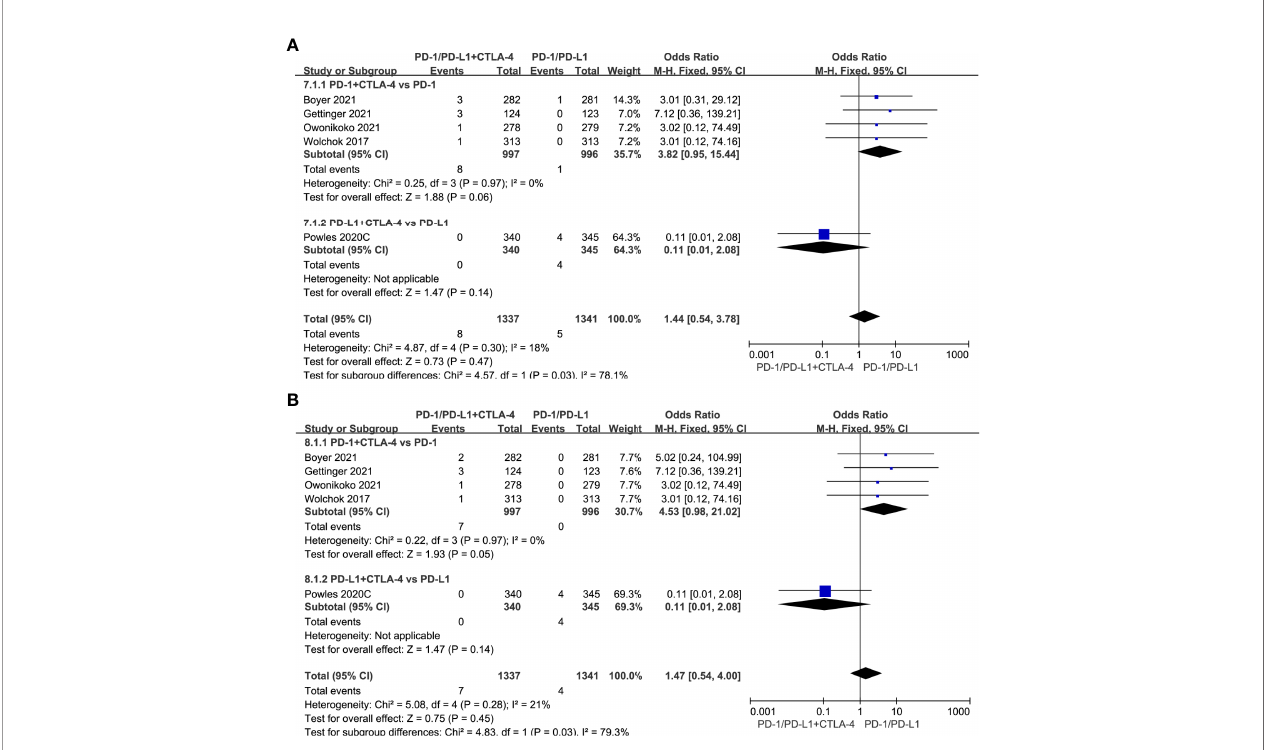
FIGURE 6 | Forest plots of the risk of all-grade and grade 3-5 cardiotoxicity calculated by the fi xed effect model. (A) The risk of all-grade cardiotoxicity in PD-1/PD- L1 inhibitors +CTLA-4 inhibitors VS PD-1/PD-L1 inhibitors group. (B) The risk of grade 3-5 cardiotoxicity in PD-1/PD-L1 inhibitors +CTLA-4 inhibitors VS PD-1/PD- L1 inhibitors